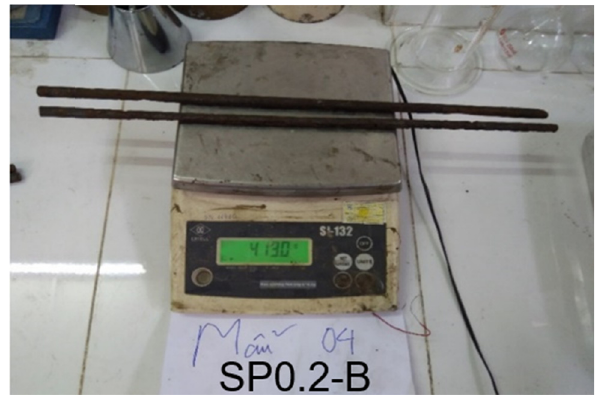
Figure 12: Percentage of mass loss of corroded reinforcement.